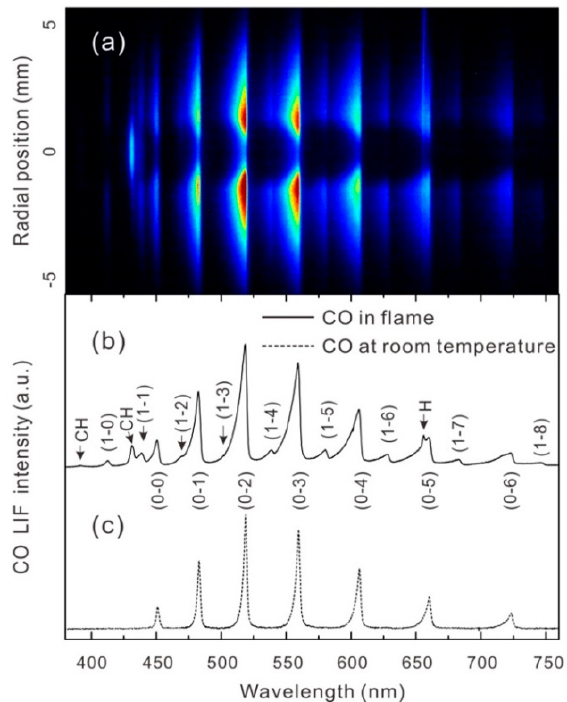
Figure 1. Spectra of CO femtosecond two-photon laser-induced fluorescence (fs-TPLIF): ( a ) Spatially resolved imaging spectrum recorded in a laminar premixed CH 4 / air jet flame ( Φ = 1.5); ( b ) integrated spectral curve of the flame; ( c ) spectral curve of a gas mixture of CO / N 2 at room temperature [27]. (© 2017 Optical Society of America ).